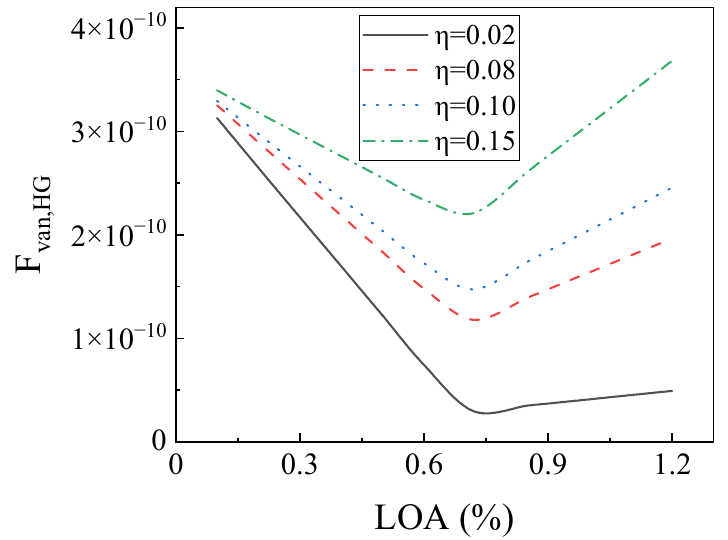
Figure 12. Van der Waals force vs. LOA under various effective surface area